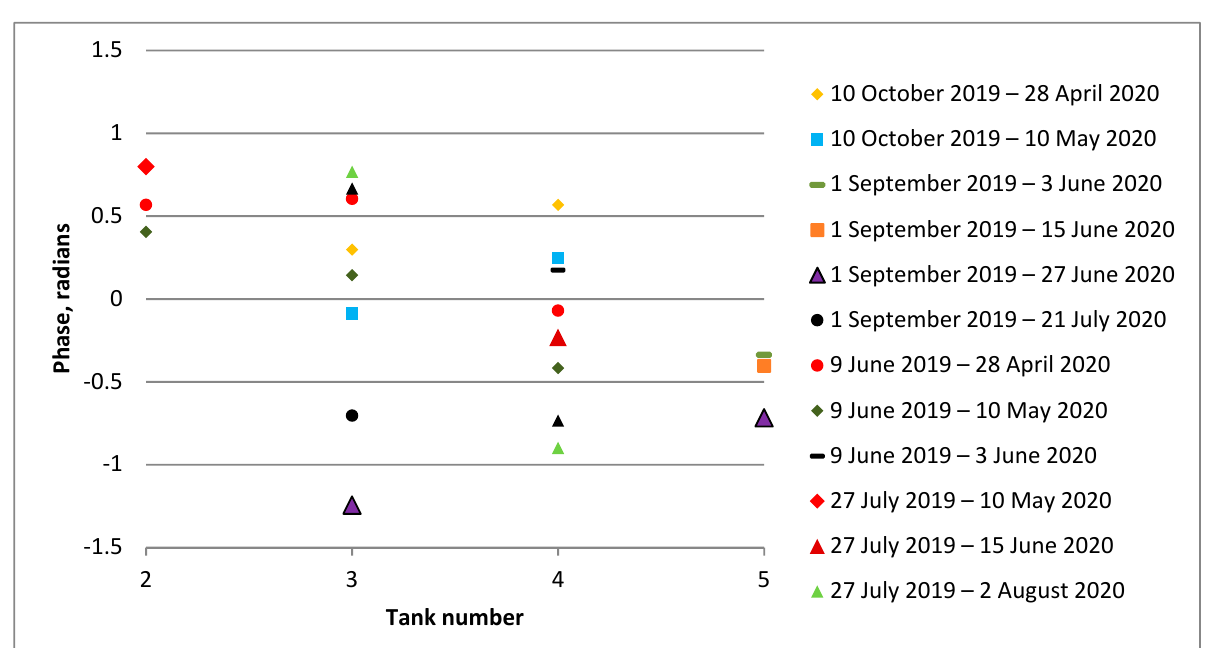
Figure 15. Phases of tanks 2–5 on the interferograms with long temporal baselines.